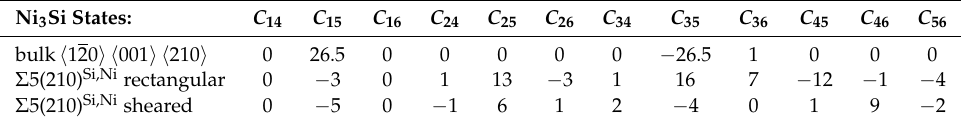
Table A1. Additional elastic constants (all in GPa) for the systems which are unstable, sheared or, in the case of the Ni 3 Si bulk, rotated into a coordination system in which the number of non-zero elastic constants is not minimum (unit cell vectors do not match the axes of the Cartesian coordination